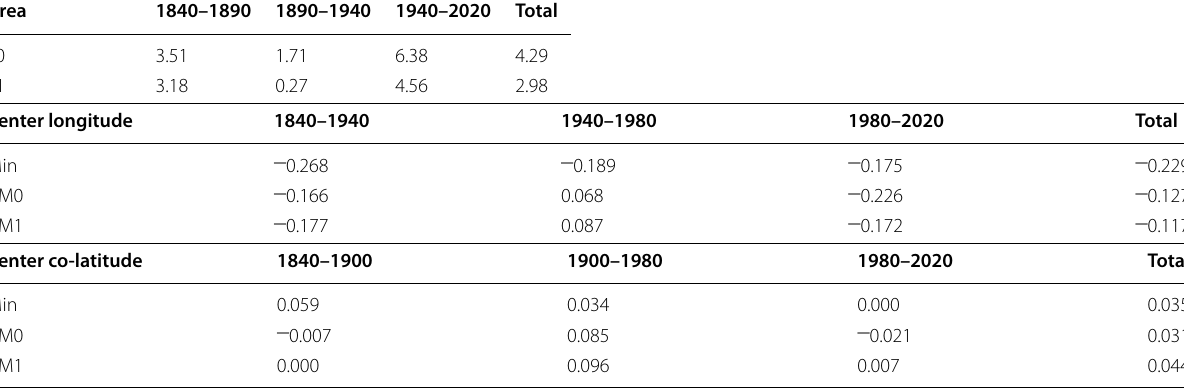
Mean rates of change are given for specific periods motivated by Fig. 4 (see text) as well as for the entire period (denoted by ‘Total’)